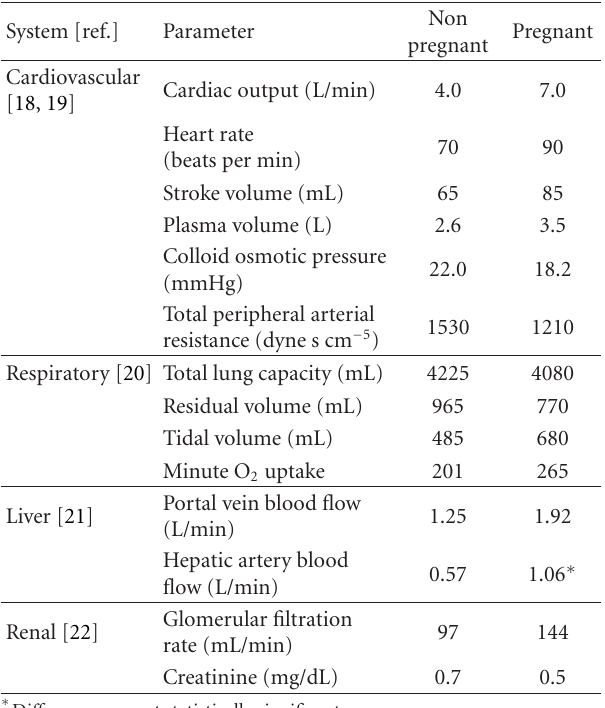
Table 1: Pregnancy-induced physiologic changes during near term. System